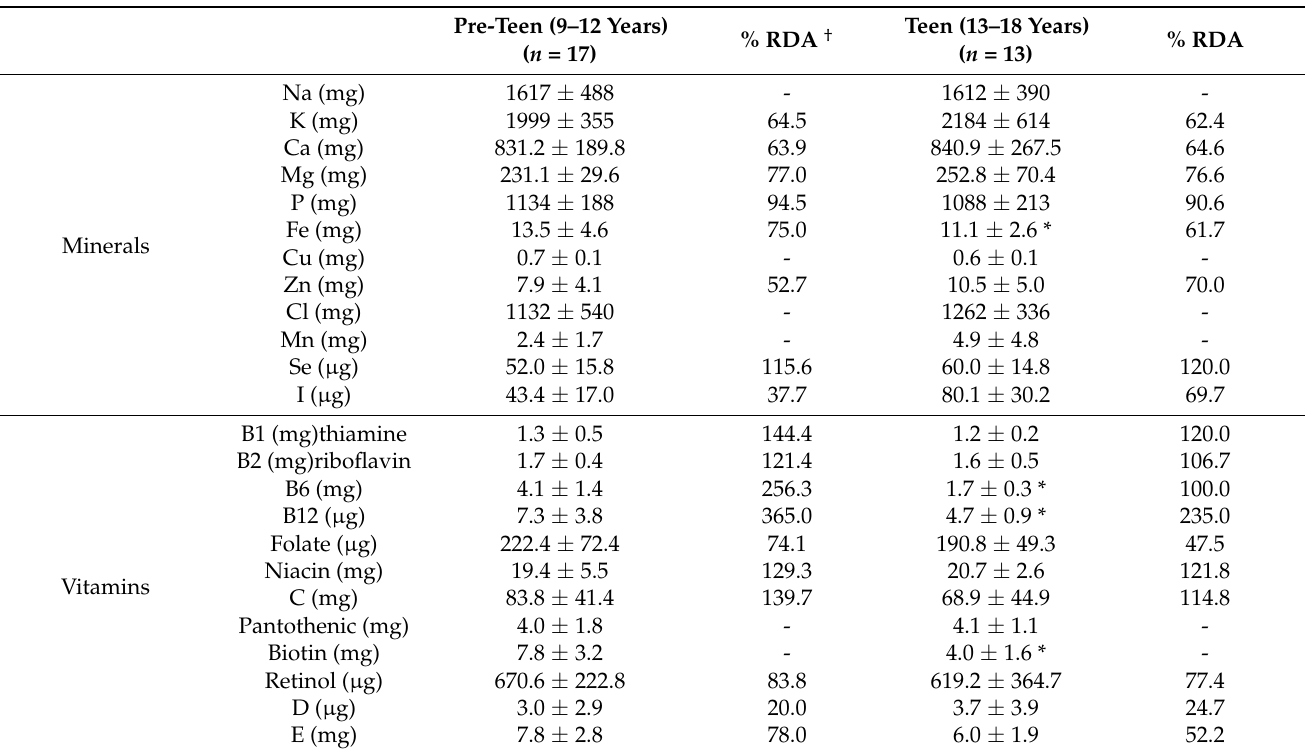
Table 4. Micronutrient intakes and percentage of RDA values in pre-teen and teen gymnast